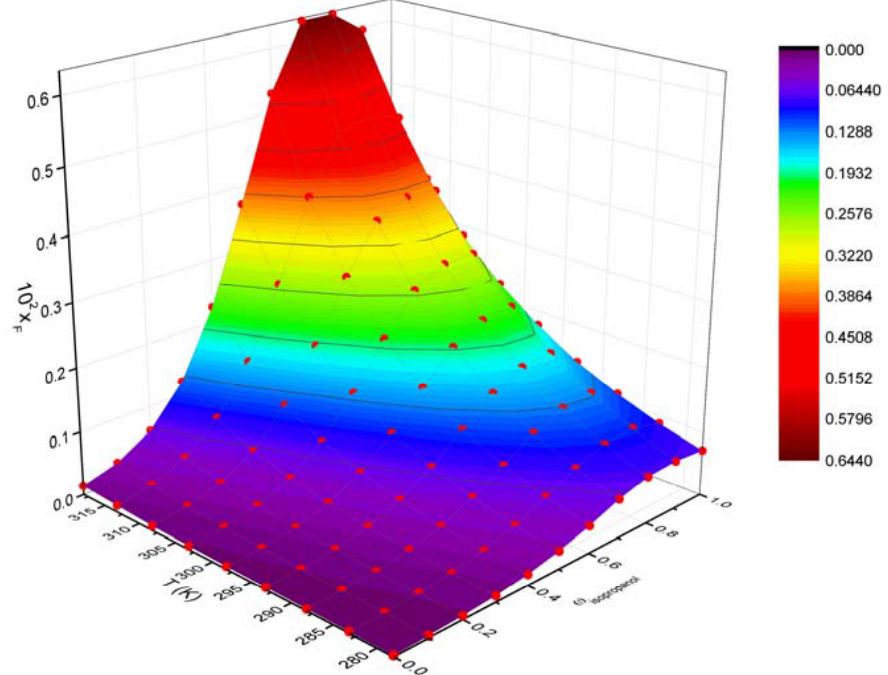
Figure 7. Molar ratio solubility data of florfenicol in isopropanol + water binary solvents at T = 278.15 K to 318.15 K.